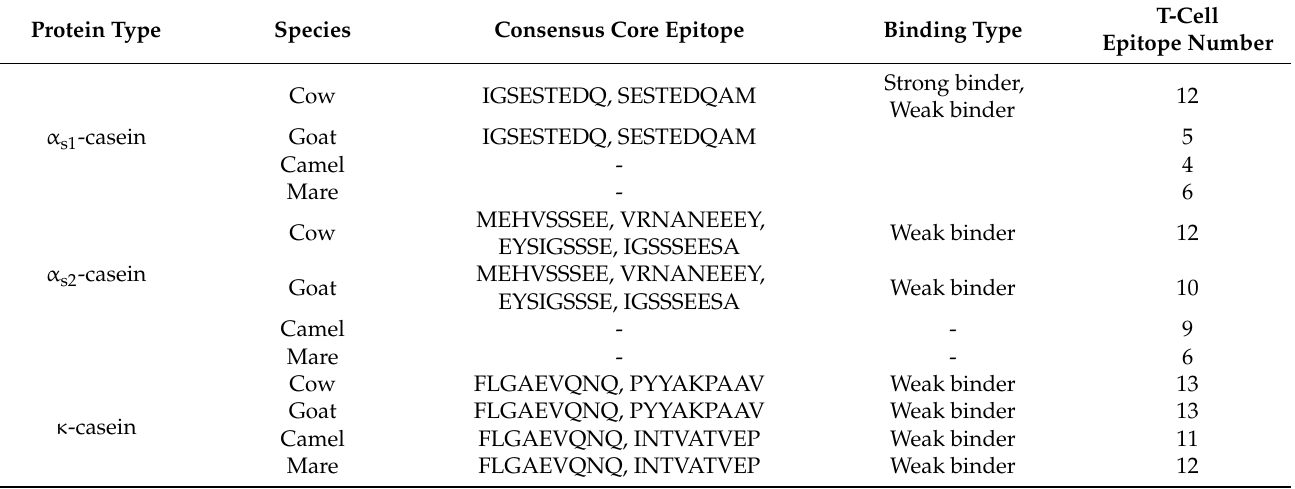
Table 4. The predicted results of the linear T cell epitopes in regard to the allergenic subtypes, respectively, in CM, GM, CAM, and